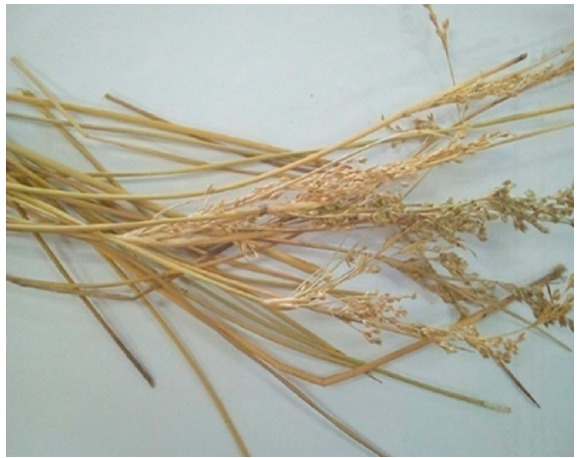
Figure 1. Rush stems (Juncus maritimus).